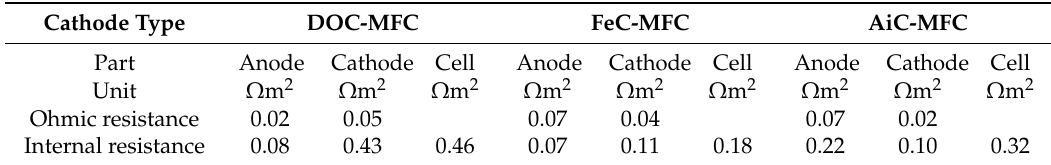
Table 1. Ohmic resistance obtained from the EIS spectra of the three cathode types: DOC, FeC and AiC in Figure 3. Data are compared with internal resistance estimated by linear regression using Figures 2a and